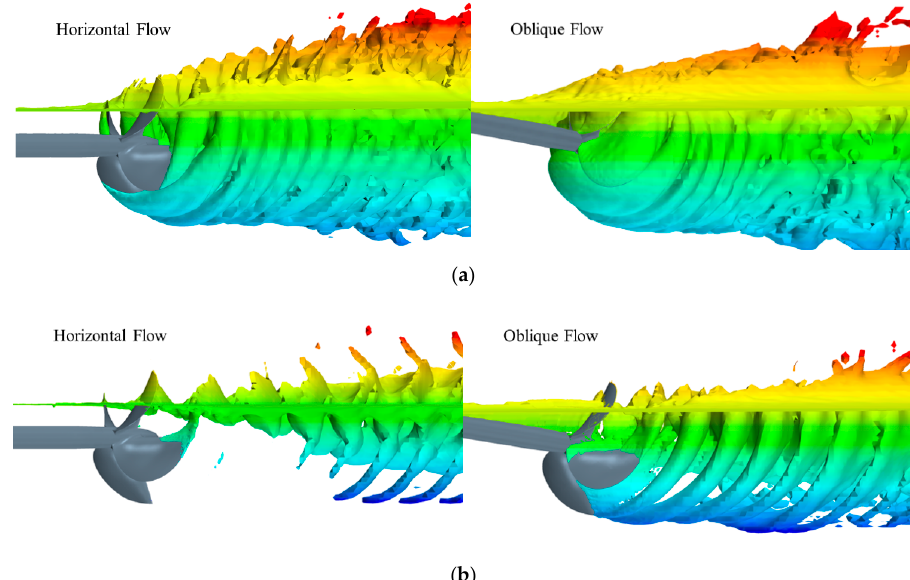
Figure 8. Free surface of SPP-1 in horizontal and oblique flow. ( a ) The free surface of SPP-1 in horizontal ( left ) and oblique ( right ) flow at J = 0.8; ( b ) the free surface of SPP-1 in horizontal ( left ) and oblique ( right ) flow at J = 1.4.